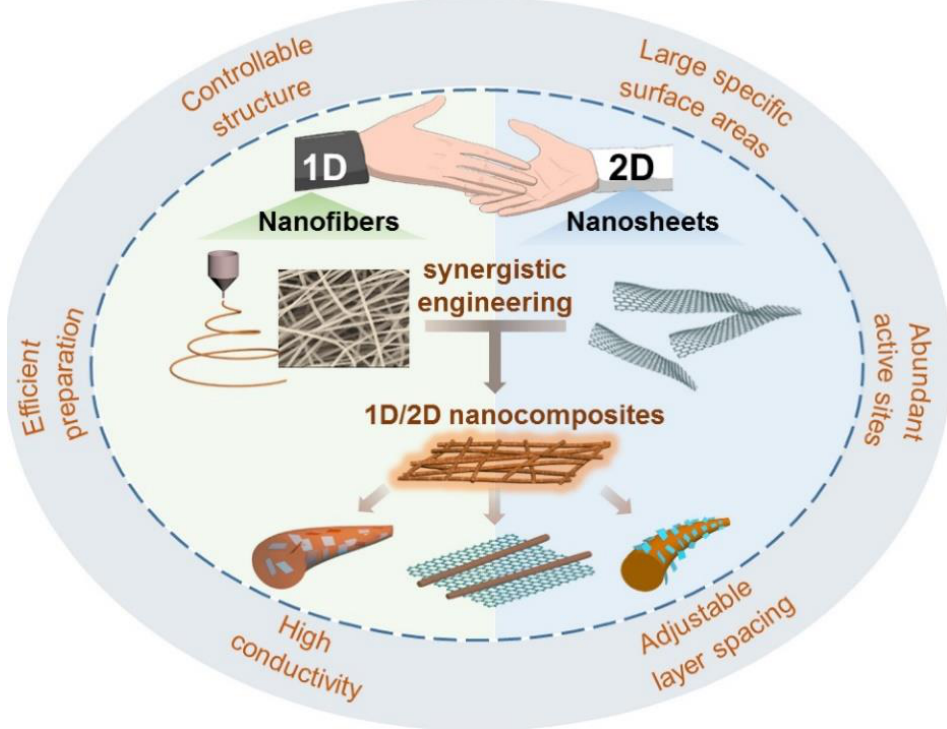
Figure 12. Hybrid Nanocomposites exhibiting outstanding properties brought by Synergistic engi- neering (reused with copyrights from Ref. [157] 2020, Elsevier). Table 4. Electrochemical properties of advanced anode material .